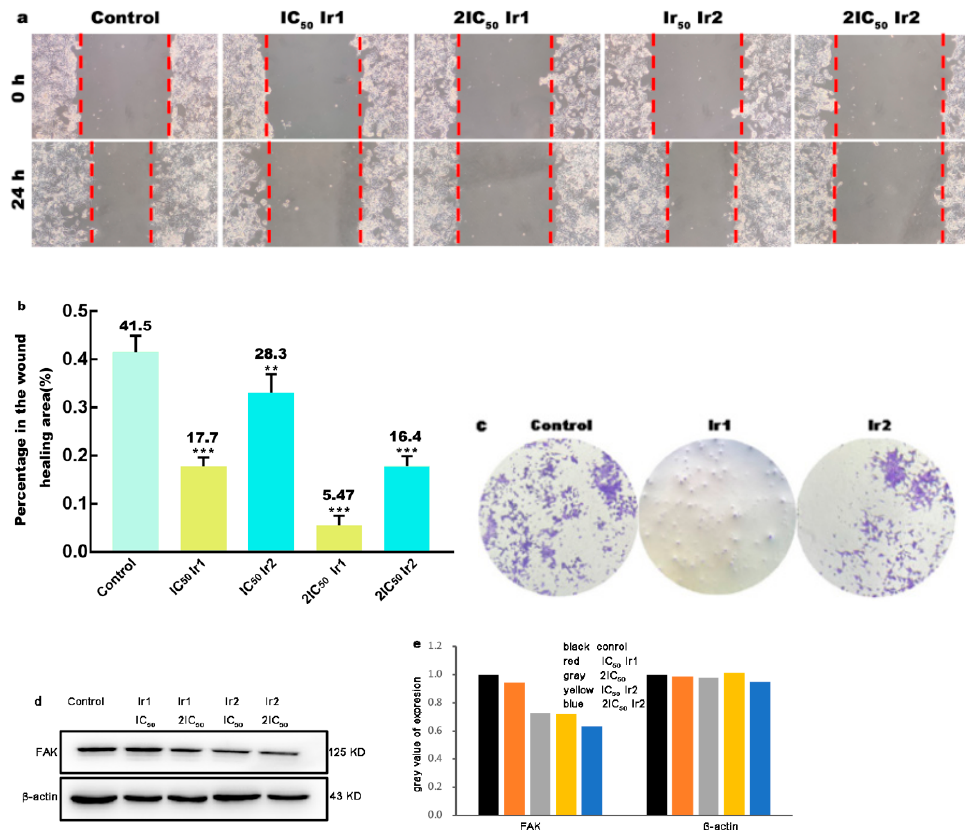
Figure 5. ( a ) Wound healing in HCT116 cells after treatment with IC 50 or 2IC 50 of Ir1 and Ir2 for 0 h and 24 h. ( b ) Wound closure of the control and Ir1 - and Ir2 -treated group. ( c ) Colony formation of HCT116 cells were exposed to IC 50 concentration of Ir1 and Ir2 for 24 h. ( d , e ) The expression of FAK protein after a 24 h treatment of HCT116 cells with IC 50 or 2IC 50 of concentrations of Ir1 and Ir2 for 24 h. β -actin was used as internal control. ** p < 0.01, *** p <